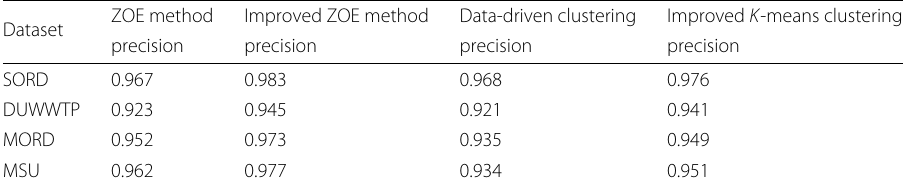
Table 4 Comparison of detection